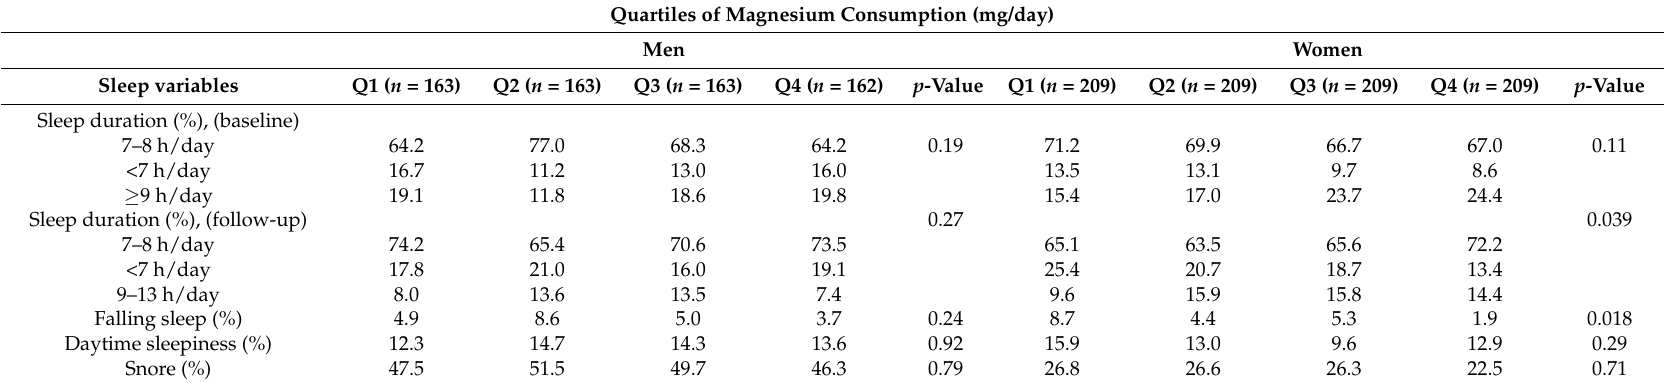
Table 2. Sex-specific sleep outcomes of subjects by quartiles of magnesium consumption at baseline (2002) ( n = 1487) 1